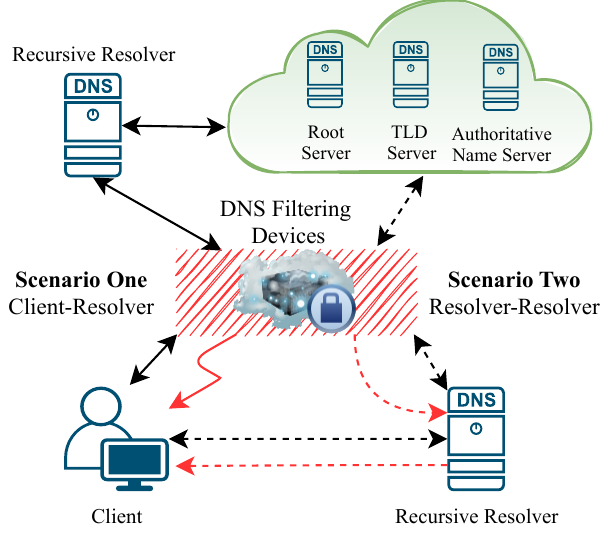
Figure 1. Standard DNS query procedure and location of DNS